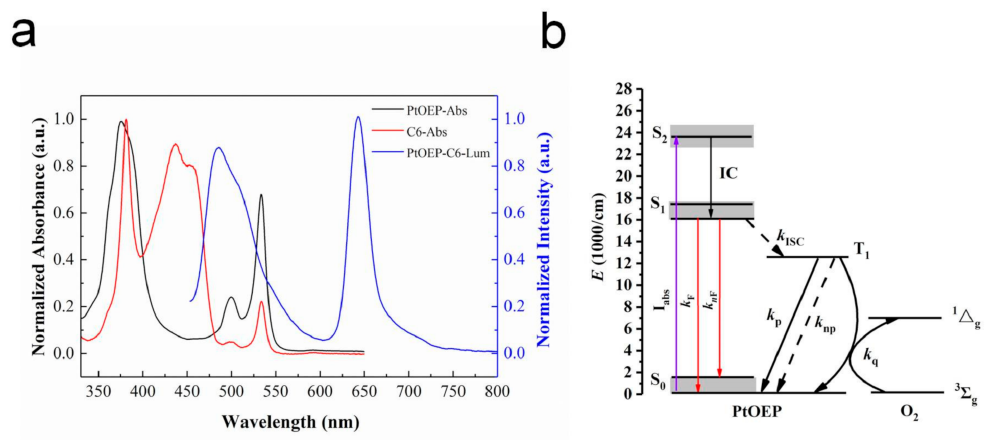
Figure 2. ( a ) Typical normalized UV-absorption spectrum (platinum octaethylporphyrin (PtOEP)—black; coumarin 6 (C6)—red) and luminescence spectrum (blue) of the PtOEP / toluene and C6 / toluene solutions; ( b ) The energy level structure of